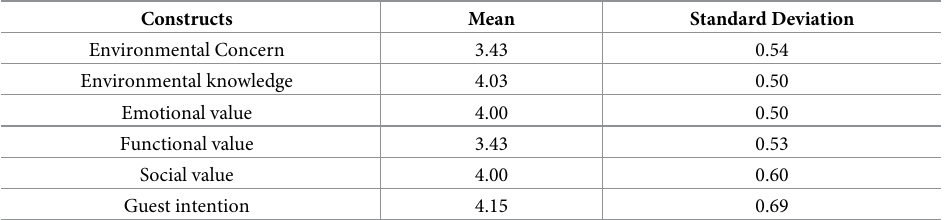
Table 2. Constructs descriptive analysis: Mean and standard